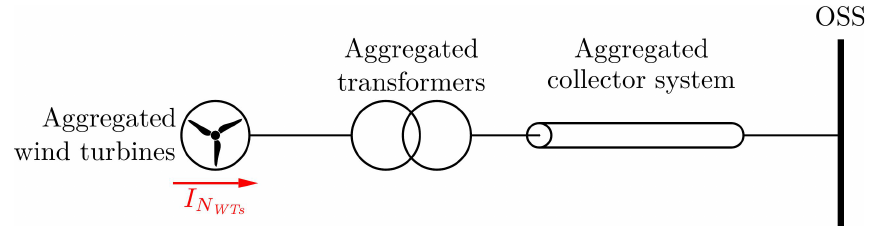
Figure 2. Conceptual aggregated